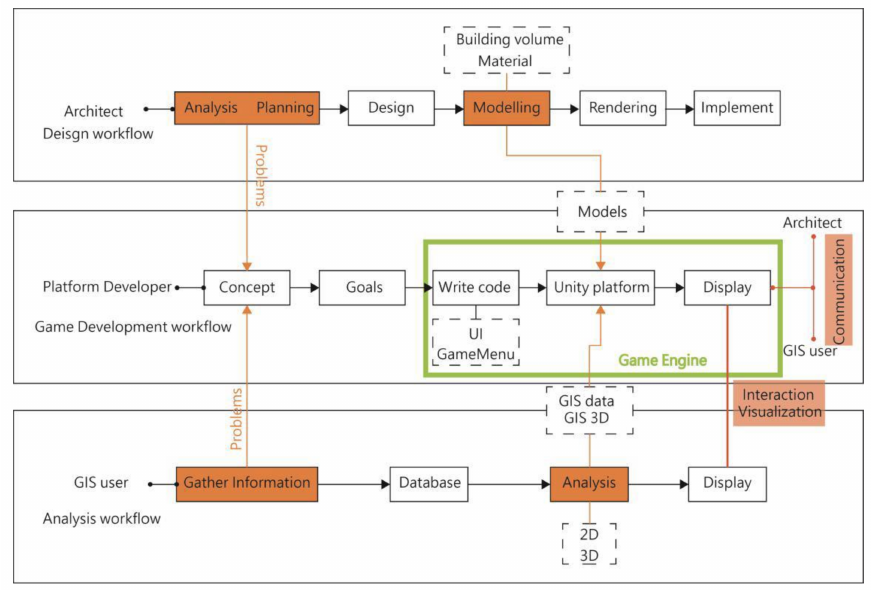
Figure 9. Contextual design for platform